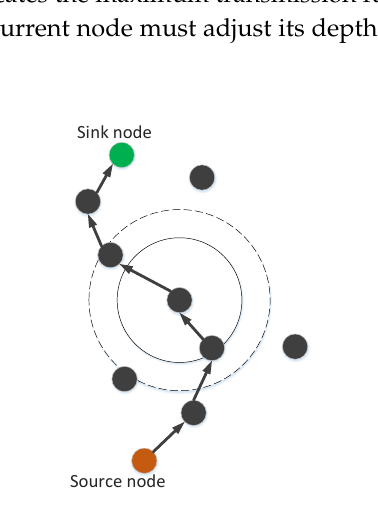
Figure 3. Transmission range